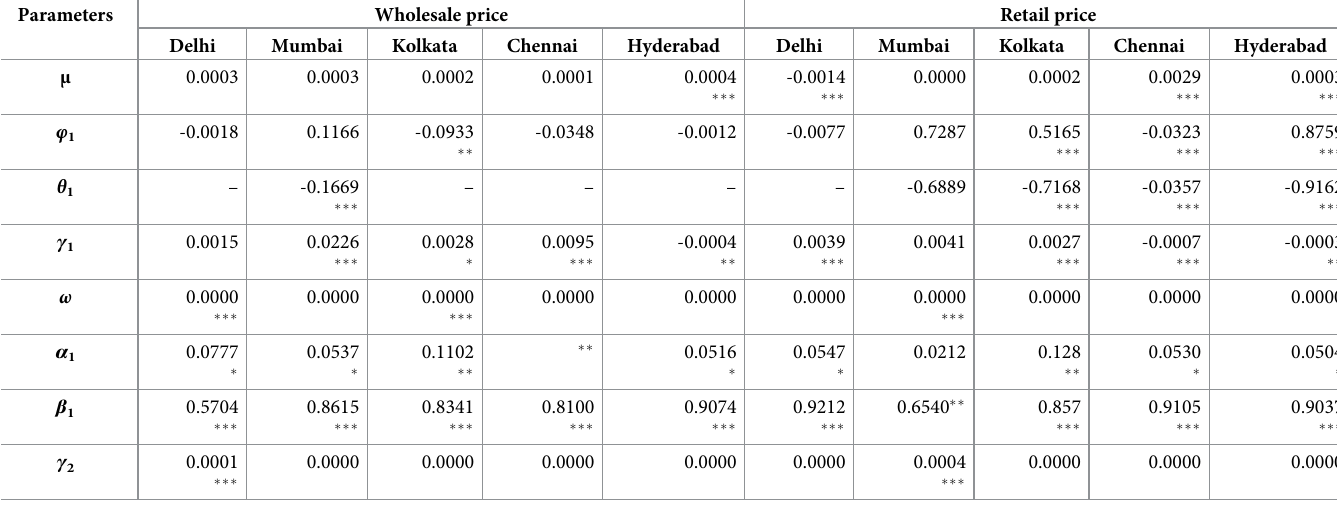
Table 5. Parameters estimate of GARCH-X model for